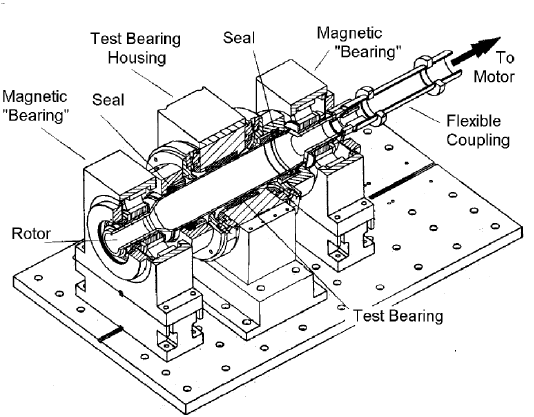
Fig. 5. Knopf and Nordmann [23] test